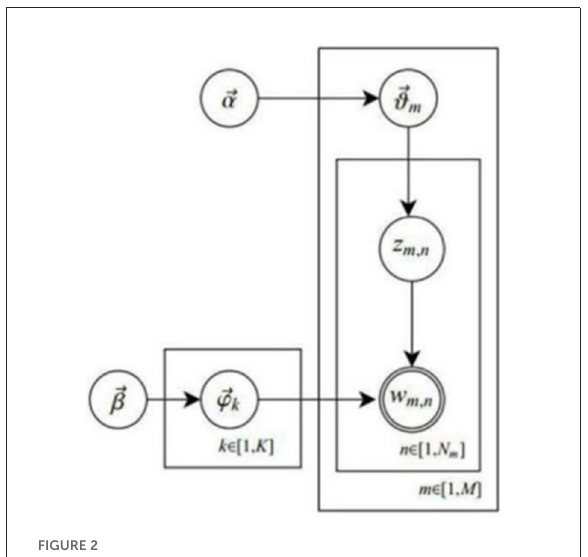
FIGURE2 LDA topic model probability